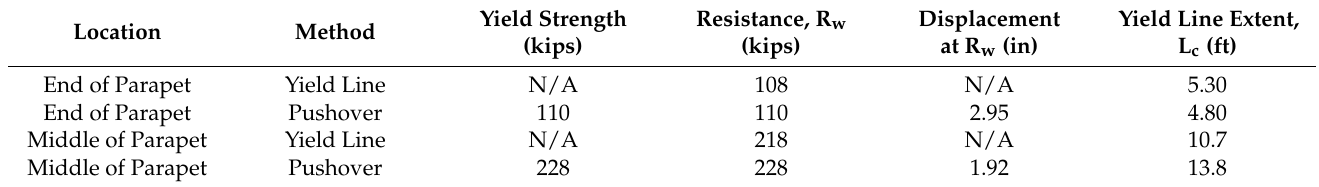
Figure 7. Force–displacement relationships and bilinearization for interior and end segments from isolated parapet model. Table 2. Comparison of Yield Line and Pushover Analysis of Fixed Base Parapet Model.